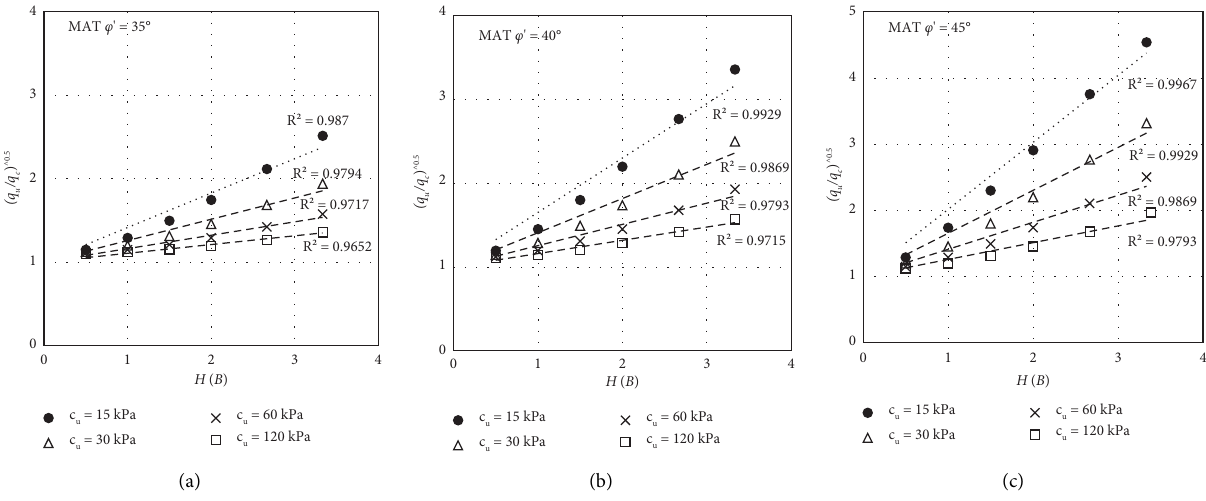
Figure 2: ( q q ) 0 . 5 versus H/B for an unstabilised granular layer (data source: Meyerhof [3]): (a) MAT ϕ ′ � 35 ° , (b) MAT ϕ ′ � 40 ° , and u / c (c) MAT ϕ ′ � 45 ° .